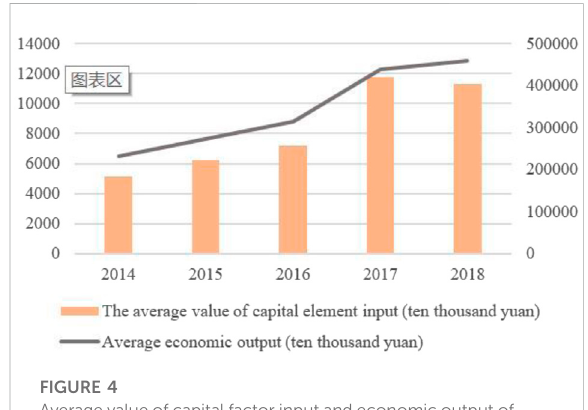
FIGURE 6 Data change of high-tech industry in Zhejiang province from 2015 to